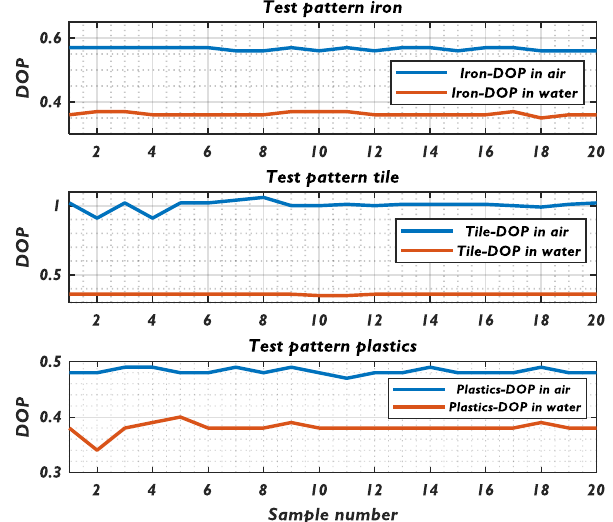
Figure 10. The degree of polarization of the same object in air and water.